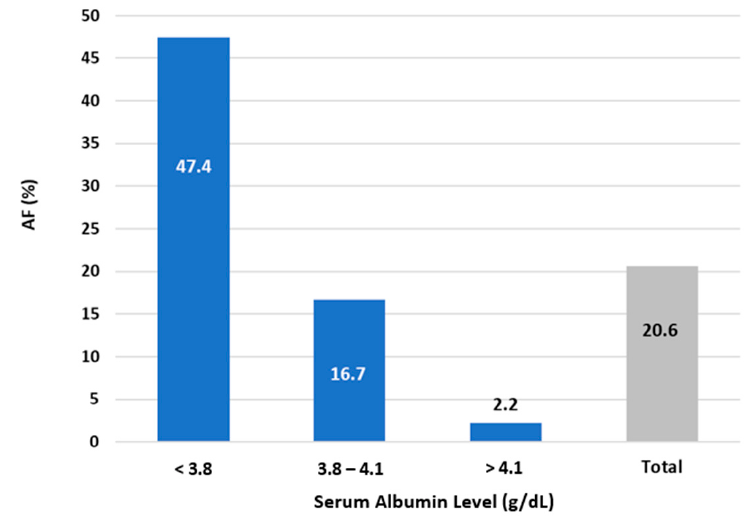
Figure 1. Atrial fibrillation (AF) recurrence rate following pulmonary vein isolation (PVI) ablation according to serum albumin (SA) level group.